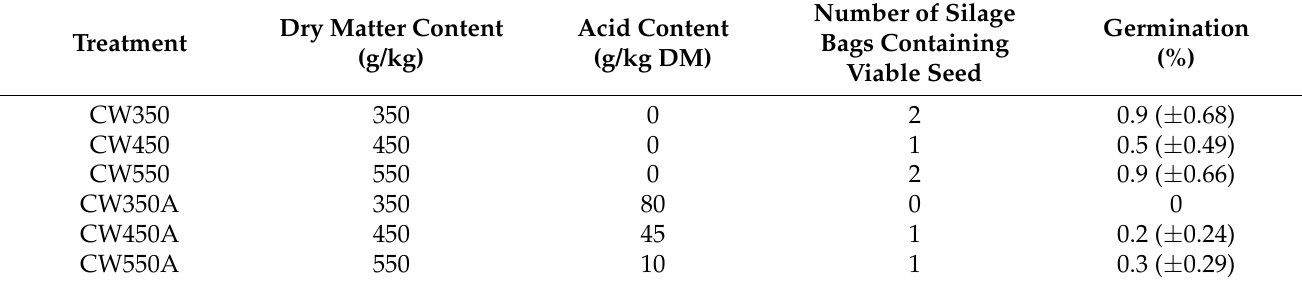
Table 5. The proportion of germinating Raphanus raphanistrum seeds present after ensiling in artificial cotton wool silage with water and acid added to achieve a range in dry matter